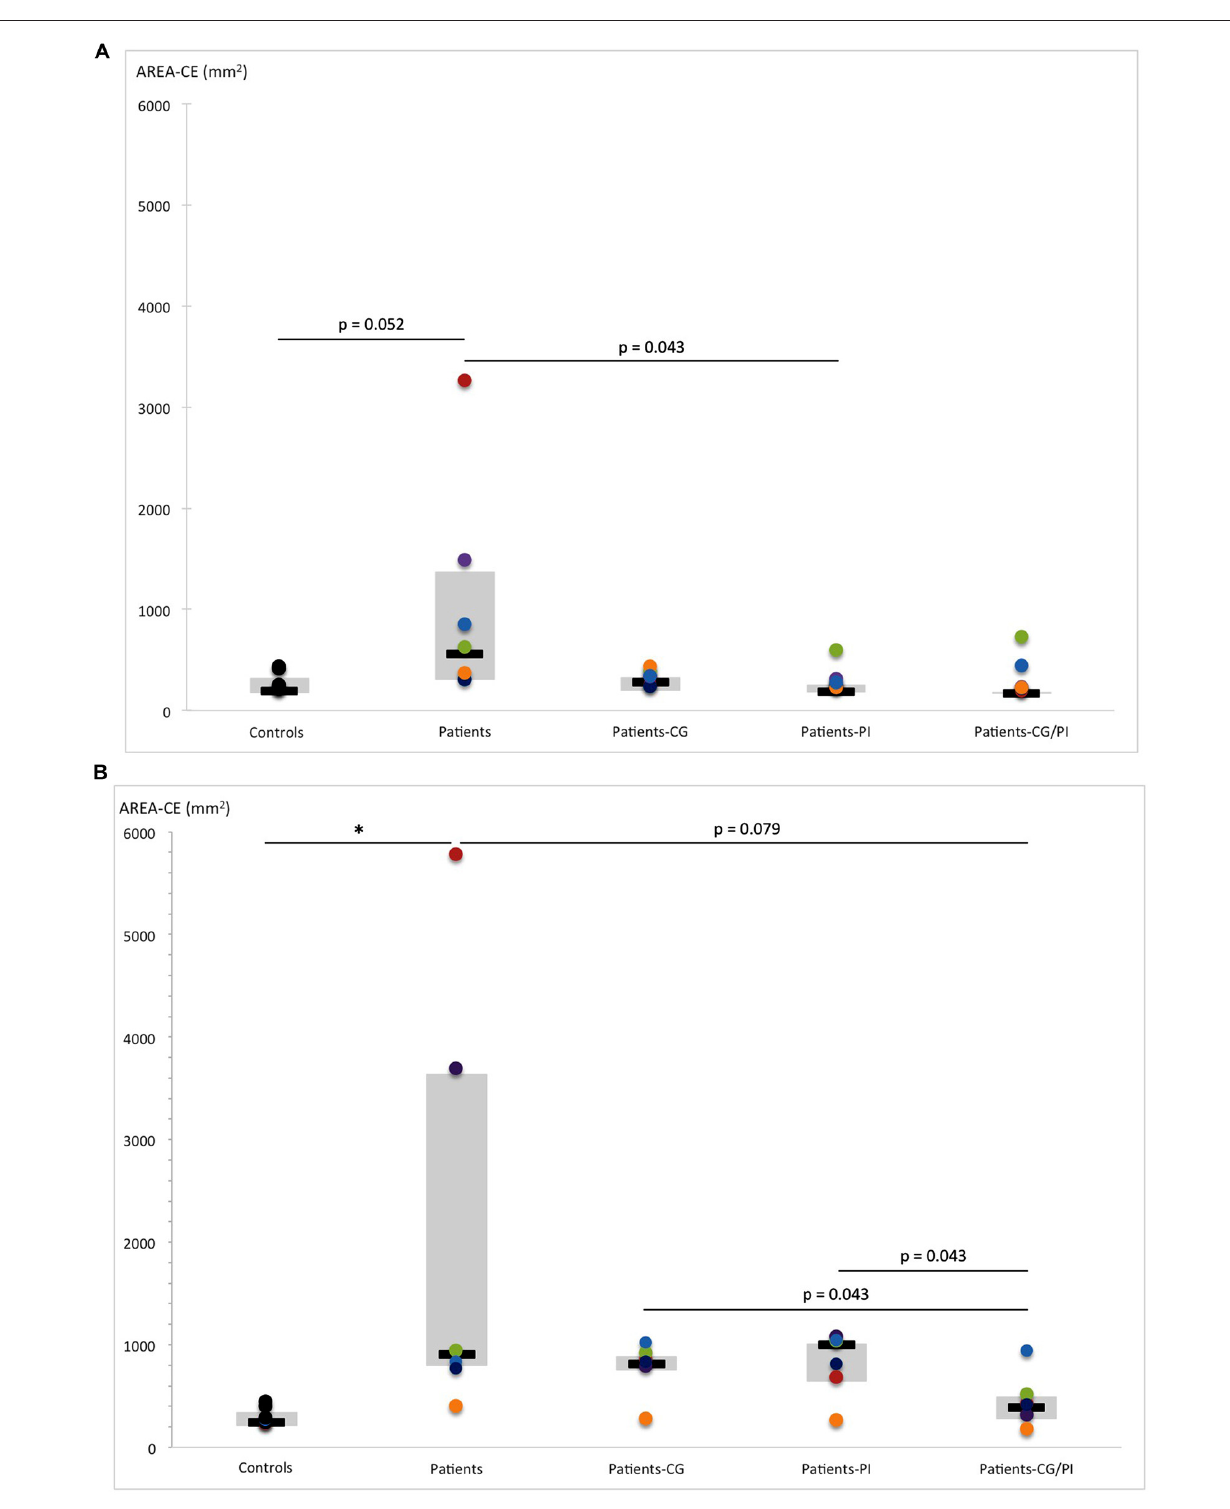
Frontiers in Human Neuroscience |